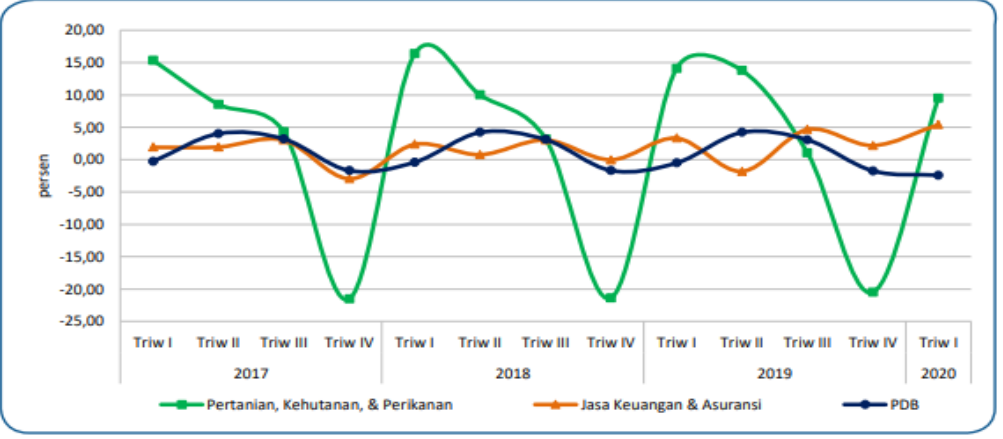
Figure 2: GDP Growth: Agriculture, Forestry & Fisheries compared to Financial Ser - vices & Insurance (q-to-q)